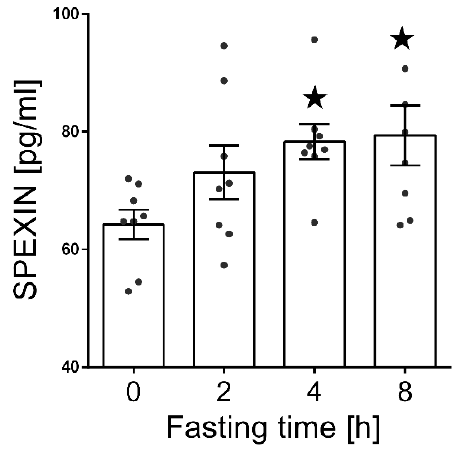
Figure 2. Serum SPX concentration changes during short-term fasting. Results are shown as the means ± SEM for each value ( n = 8). The dots represent the individual values obtained. Statistically significant changes are marked as asterisk symbol * p < 0.05 compared to time 0.